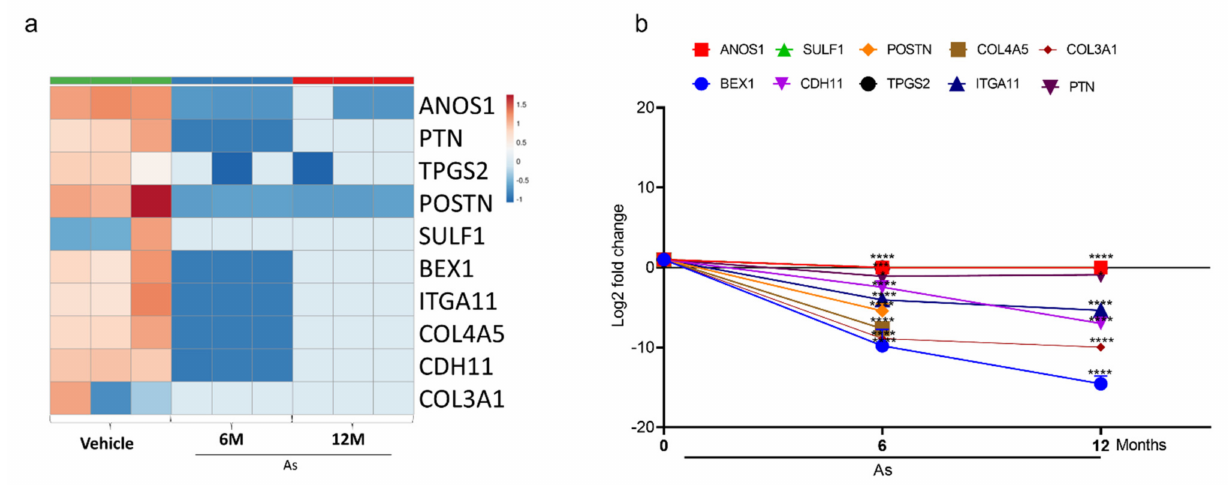
Figure 5. Expression validation of selected genes (RNA-seq datasets) using qRT-PCR. Heatmap analysis showing the expression level of top 10 downregulated genes ( a ) in RNA-seq datasets. The expression for downregulated genes ( b ) was determined by quantitative RT-PCR in successive stages of transforming cells (0, 6, and 12 months). Expression levels were normalized to β -actin. Error bars indicate the standard deviation of triplicates. One-way ANOVA was used to calculate the statistical significance between vehicle control and treatment at each time point. * p < 0.05, *** p < 0.001, and **** p < 0.0001.